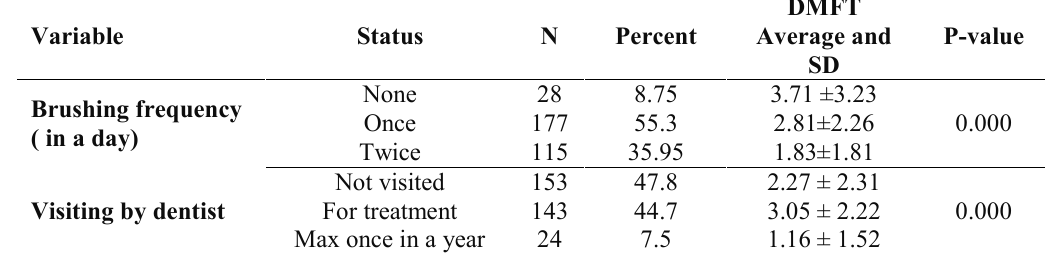
Table 3 The results of relationship between the average DMFT and frequency of brushing and dental